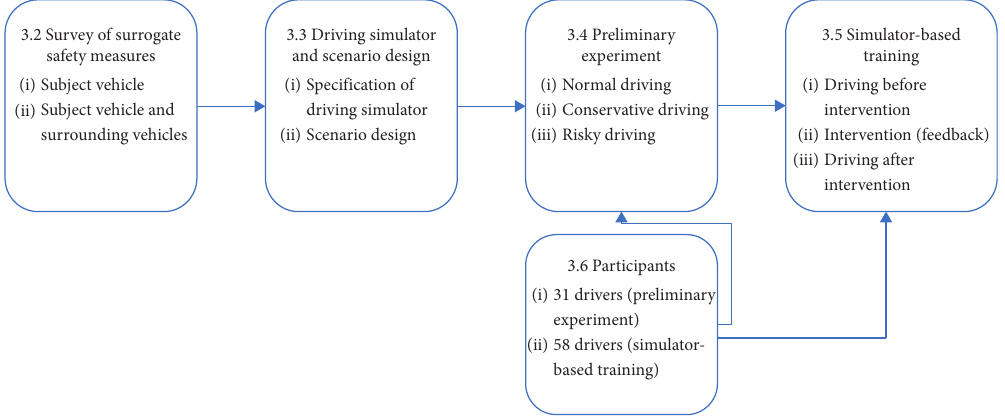
Figure 1: Framework of the study.